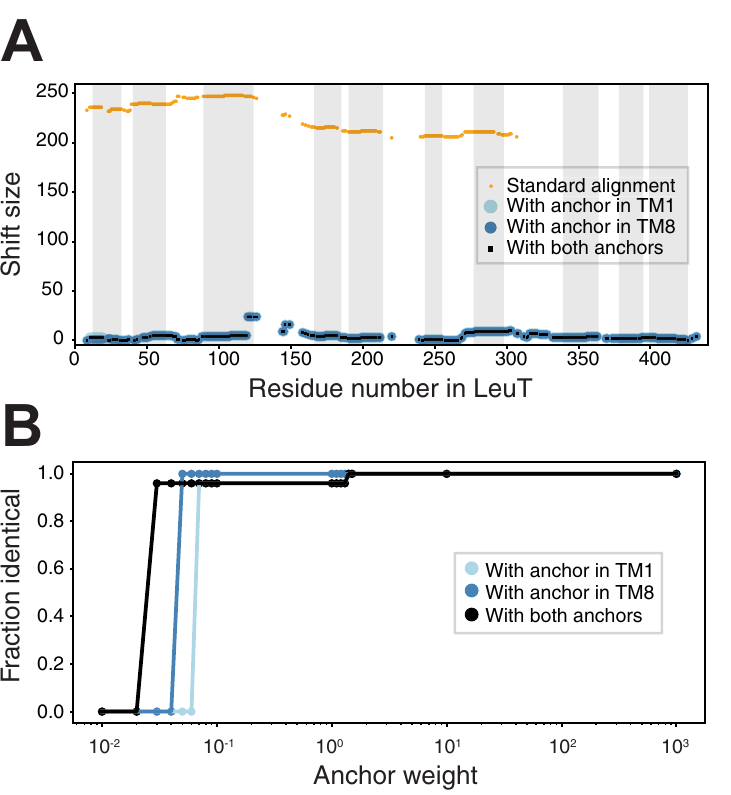
Fig 4. The effect of anchors on alignments of the membrane proteins BetP and LeuT. (A) The shift discrepancy, relative to a reference structure-based alignment, is plotted for each residue in LeuT, for alignments obtained either with the standard methodology ( orange ) or with anchors imposed ( light blue , dark blue or black ). The anchors are designed to target individual sodium-coordinating residues in the first or eighth transmembrane segment of the core LeuT fold, either separately ( light and dark blue ) or simultaneously ( black ). The approximate transmembrane regions of LeuT are indicated by gray boxes. Note that residues aligned to gaps are not scored. (B) Dependence of the alignment on the weight of the anchor, W , measured as the fraction of positions that are the same as in the alignment obtained using W = 1000. Alignments obtained with W > 2 are the same as those obtained with W = 1000, for all combinations of the two anchors. Weights smaller than 2 are not sufficient to overcome the contributions of other components of the similarity scores.